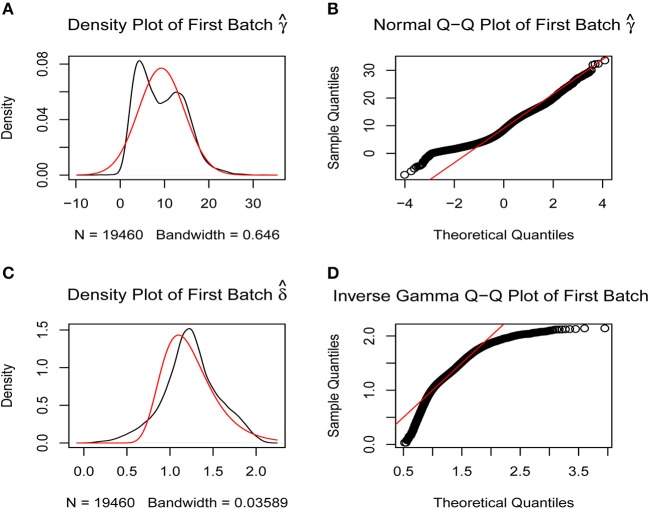
Removal of batch effects. The closer the scatter is to the straight line, the smaller the batch effect is. (A,B) Batch effects between the two platforms were corrected using SVA R package by normal Q-Q plot. (C,D) Batch effects between the two platforms were corrected using SVA R package by inverse gamma Q-Q plot.